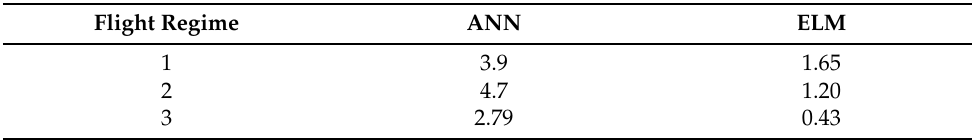
Table 7. Mean training time (in arbitrary CPU